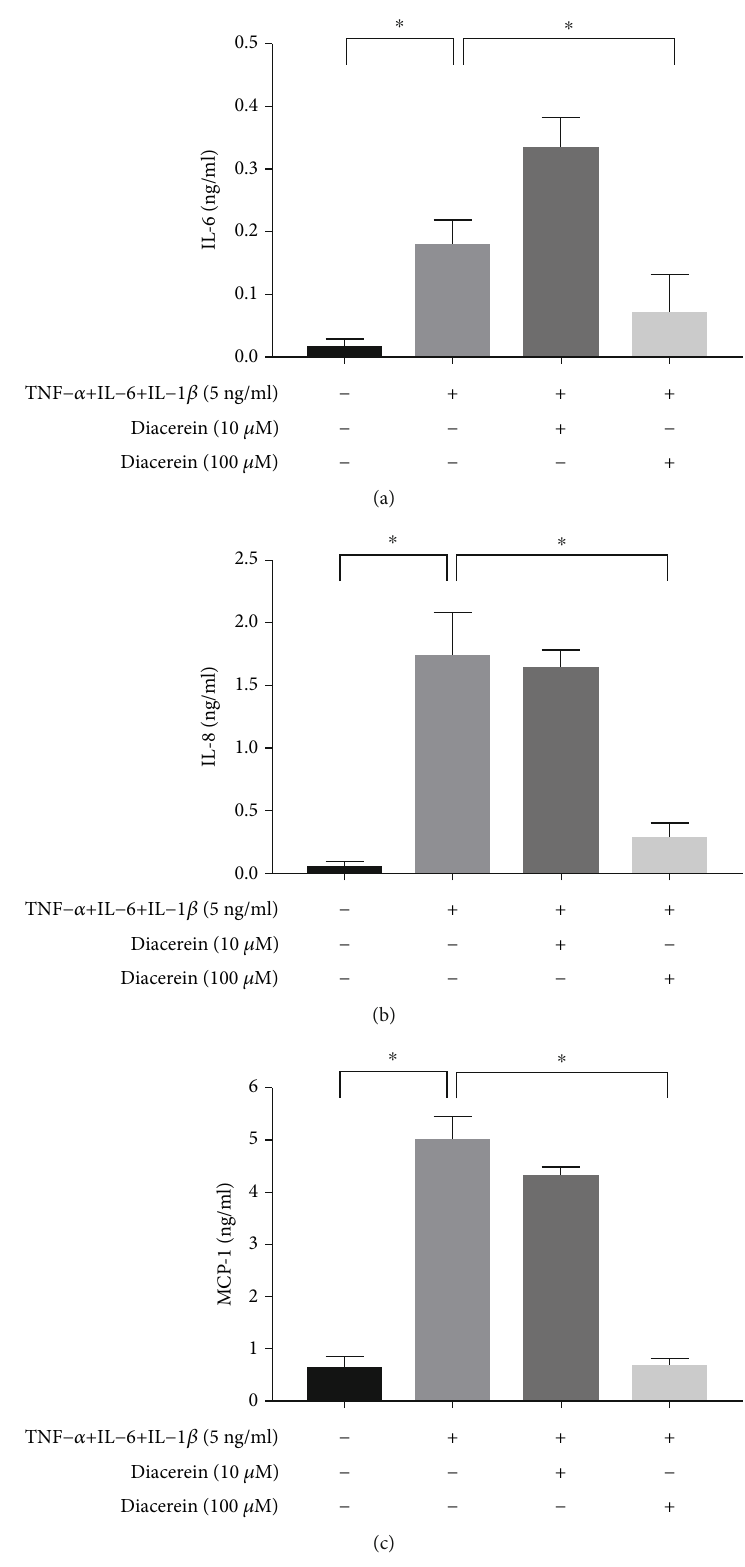
Figure 5: Diacerein protects against cytokine-induced in fl ammation in ARPE-19 cells. The levels of (a) IL-6, (b) IL-8, and (c) MCP-1 in ARPE-19 cells were measured using the ELISA Ready-Set-Go kit. Diacerein (100 μ M) signi fi cantly suppressed the expression of IL-6, IL-8, and MCP-1 induced by TNF- α +IL-6+IL-1 β . The data are expressed as mean ± SD of three independent experiments. ∗ p < 0 : 05 compared with the control